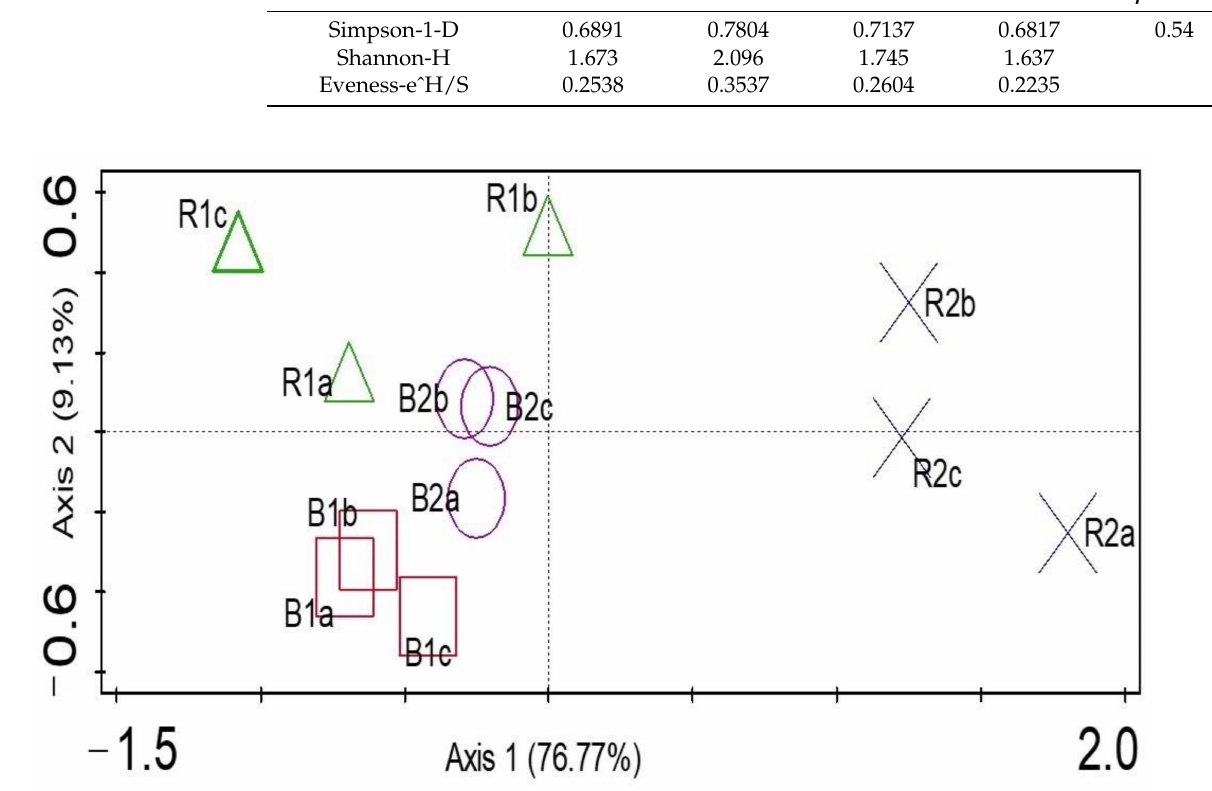
Figure 5. Principal coordinates analysis (PCoA) for genus derived from rhizosphere (R1 and R2) and bulk soil samples (B1 and B2) in Palmietfontein (R1, B1) and Bloemhof (R2,